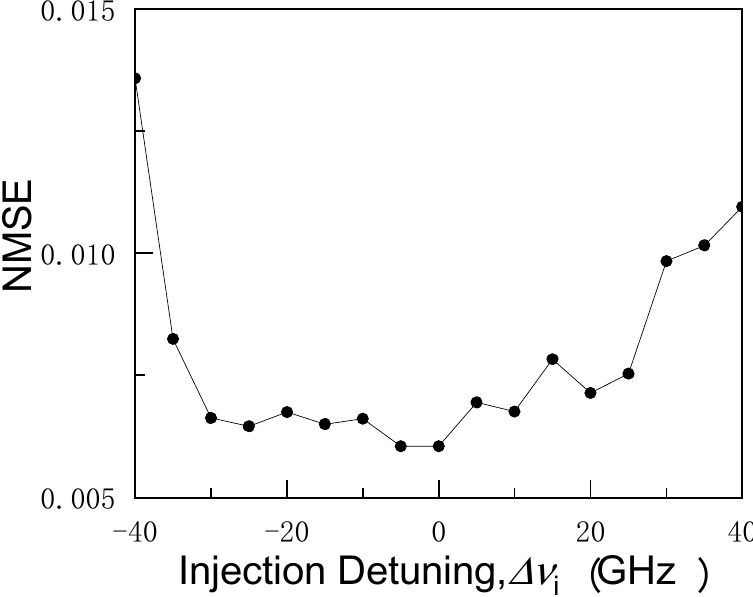
∆ ν = 12 ns − 1 and k s = 14 ns − 1 . i when k i = 12 ns (cid:2879)(cid:2869) and 𝑘 = 14 ns (cid:2879)(cid:2869) . Figure 5. Measured NMSE as a function of when 𝑘 (cid:3036) (cid:3036) (cid:3046)